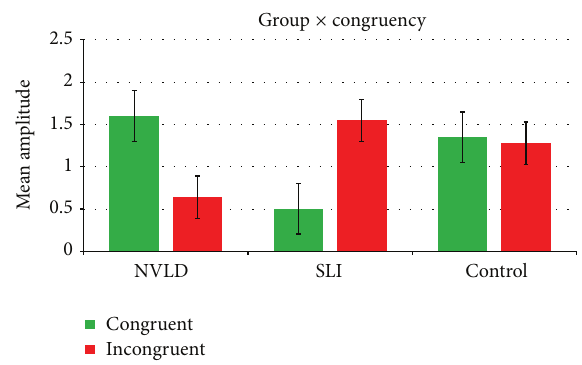
Figure 5: Mean amplitudes of ERPs elicited by congruent and incongruent stimuli in the three groups. Error bars represent standard